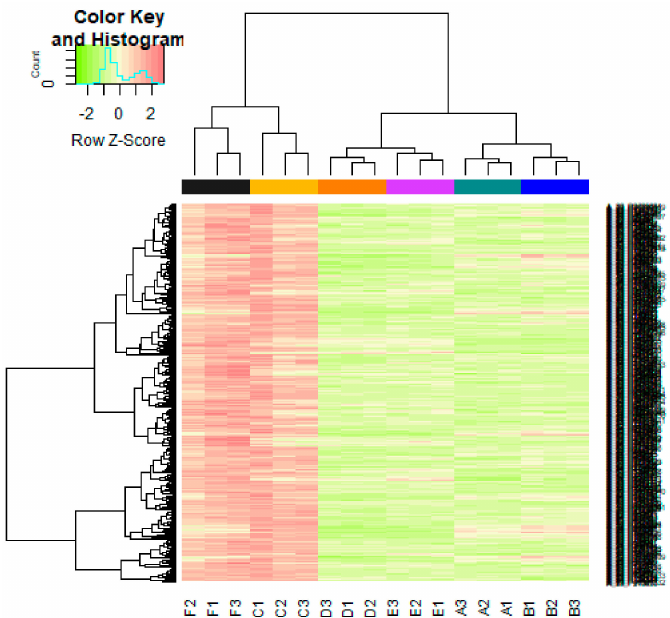
Figure 5. Heat map of down-regulated di ff erentially expressed genes. The legend on the top left indicates log fold change of genes. (A1, A2, A3 = T47D (wild type genotype + estradiol); B1, B2, B3 = T47D (wild type genotype + none); C1, C2, C3 = T47D (wild type genotype + tamoxifen); D1, D2, D3 = T47D (overexpressing Split Ends (SPEN) + estradiol); E1, E2, E3 = T47D (overexpressing Split Ends (SPEN) + none); F1, F2, F3 = T47D (overexpressing Split Ends (SPEN) +